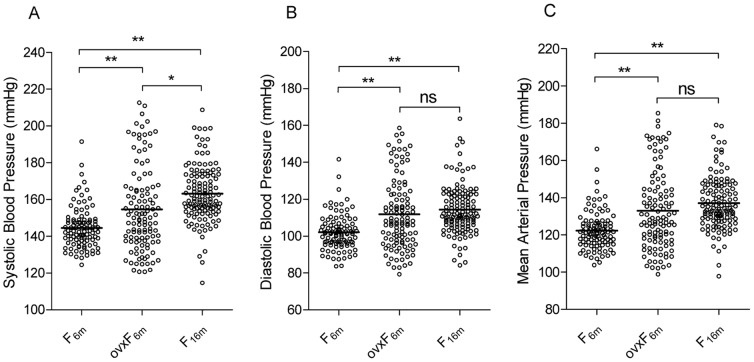
Distribution of BP in male, pre-menopausal and post-menopausal F2 (Dahl S×R)-intercross cohorts.Distribution of systolic (A), diastolic (B) and mean (C) blood pressures in pre-menopausal F2 (F6m, n = 102) female hybrids at 6 months of age (8% NaCl challenge begun at 3 months of age); ovariectomized female F2 (ovxF6m, n = 116) hybrids at 6 months of age (8% NaCl challenge begun at 3 months of age) and post-menopausal F2 (F16m, n = 130) female hybrids at 16 months of age (8% NaCl challenge begun at 14 months of age). Means are shown as horizontal lines. *
P<0.001, **
P<10−4 (one-way ANOVA followed by Tukey test for multiple comparisons).